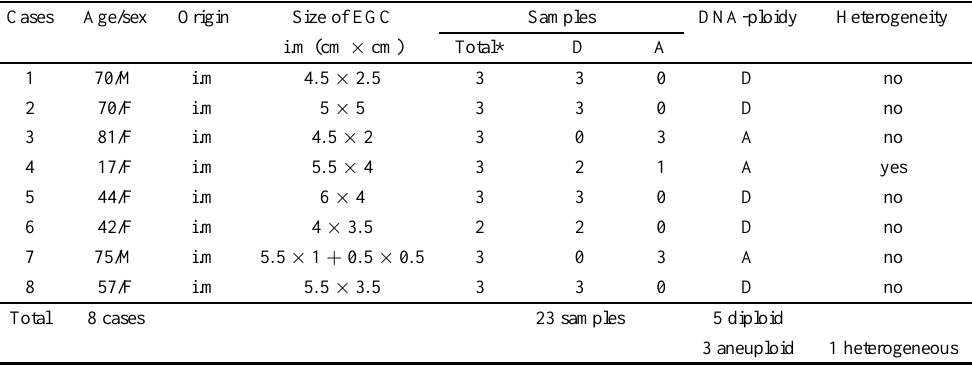
DNA-ploidy pattern in pure intramucosal